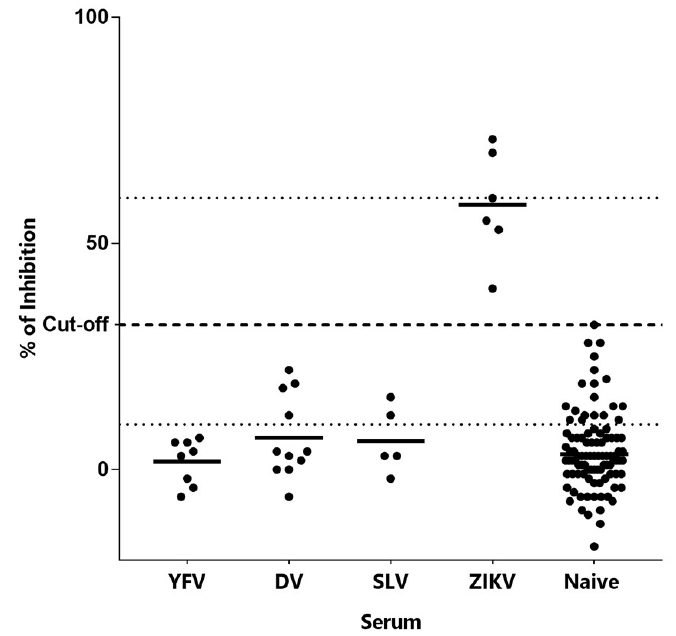
Figure 5. Inhibition achieved by flavivirus convalescent sera. Samples of Yellow Fever Virus (YFV), Dengue Virus (DV), Saint Louis Virus (SLV) and Zika Virus (ZIKV) as well as naïve sera were examined in duplicates.